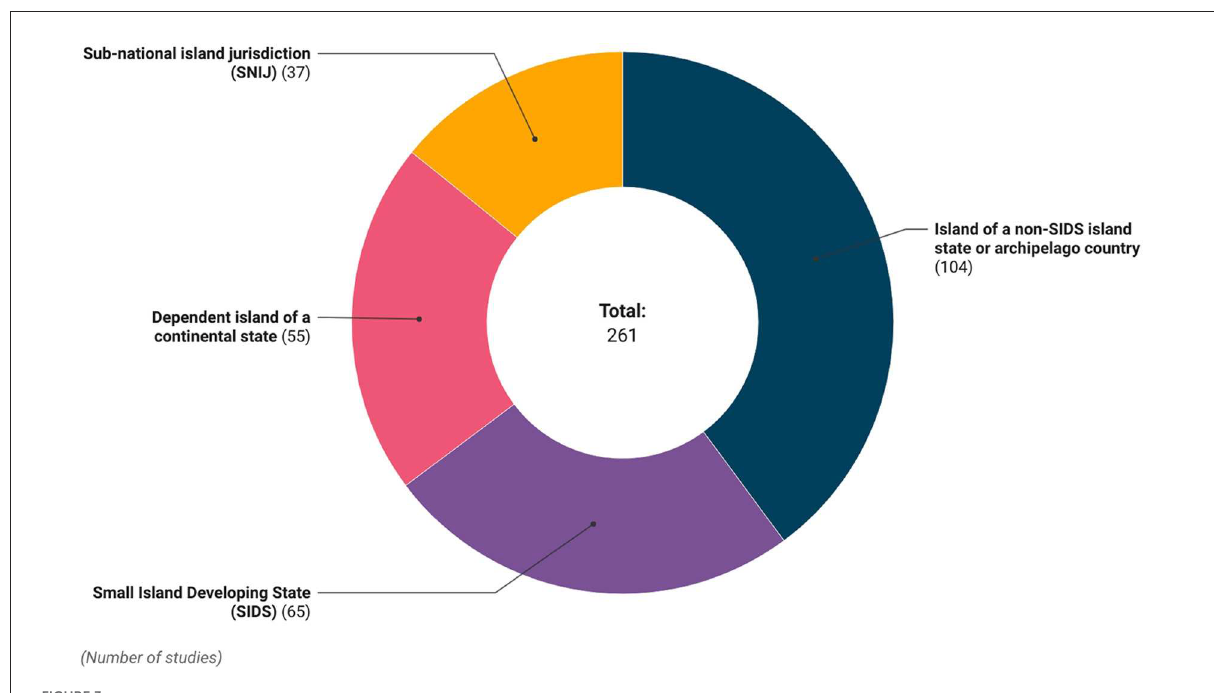
FIGURE3 Distribution of island case studies per political status.